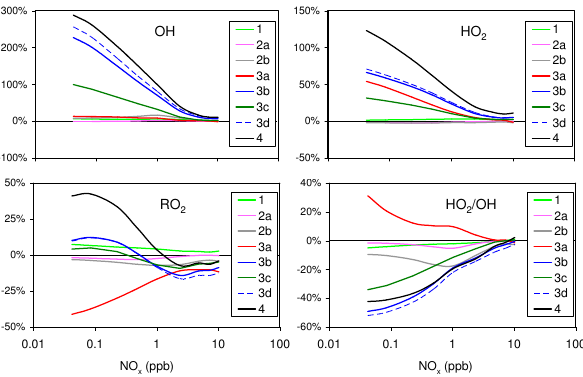
Fig. 4. Changes in mixing ratios of OH, HO 2 and RO 2 , and the HO 2 /OH ratio, for each mechanistic variant relative to MCM v3.1 (Mechanism 0). Continuous changes as a function of the simulated NO x level obtained by interpolation of the data shown in Fig. 3.